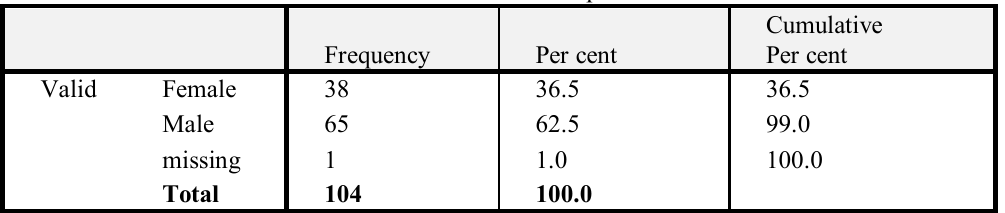
Table 1: Gender of